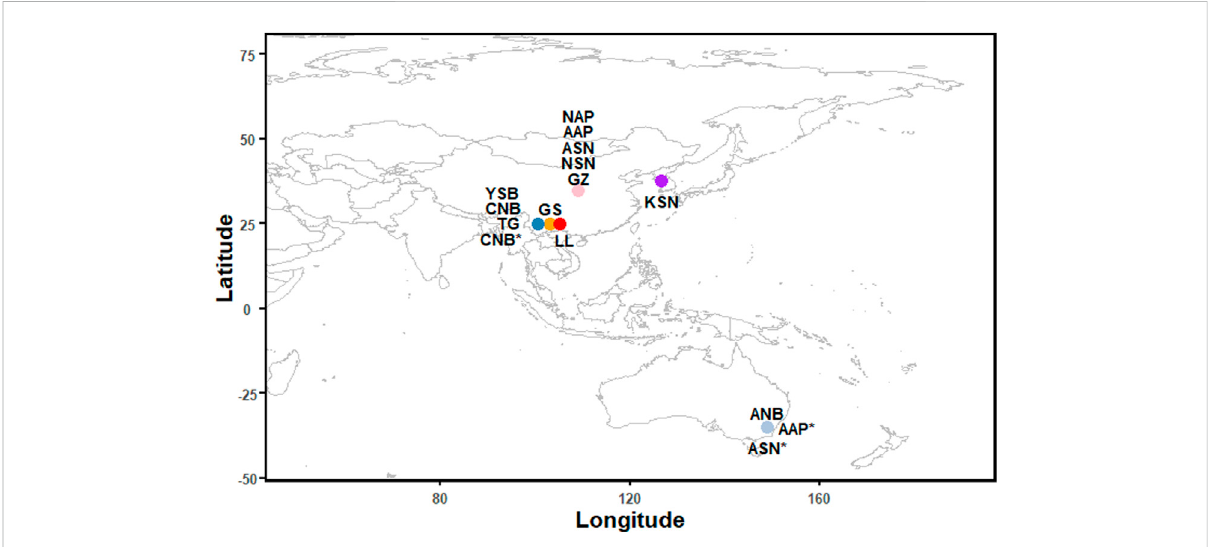
FIGURE 1 Sample information and geographic distribution of the 89 goats included in this study. [Guishan goat (GS, n = 6), Yunshang black goat (YSB, n = 6), Toggenburg (TG, n = 6), and Chinese Nubian (CNB, n = 6) were collected from Yunnan Province, Guanzhong dairy goat (GZ, n = 6), Australian Saanen(ASN, n =6),NewZealandSaanen(NSN, n =6),AustralianAlpine(AAP, n =2)andNewZealandAlpine(NAP, n =4)werecollectedfromShanxi Province.AustralianAlpine*(AAP*, n =5),Longlingoat(LL, n =15),AustralianNubian(ANB, n =5),ChineseNubian*(CNB*, n =4),KoreanSaanen (KSN, n = 10), Australian Saanen* (ASN*, n = 2) were downloaded from